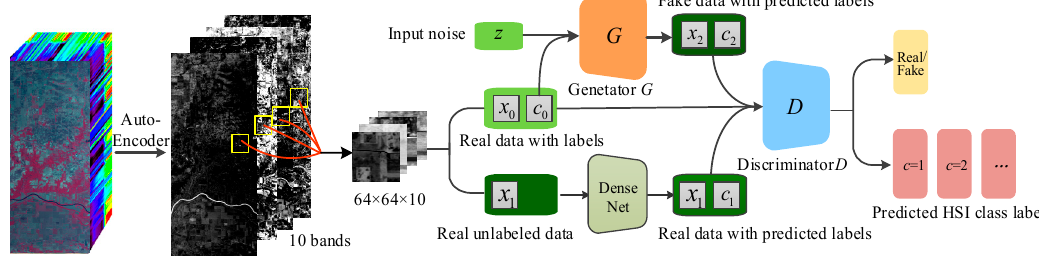
Figure 3. The framework of HSI semi-supervised fine-grained classification.